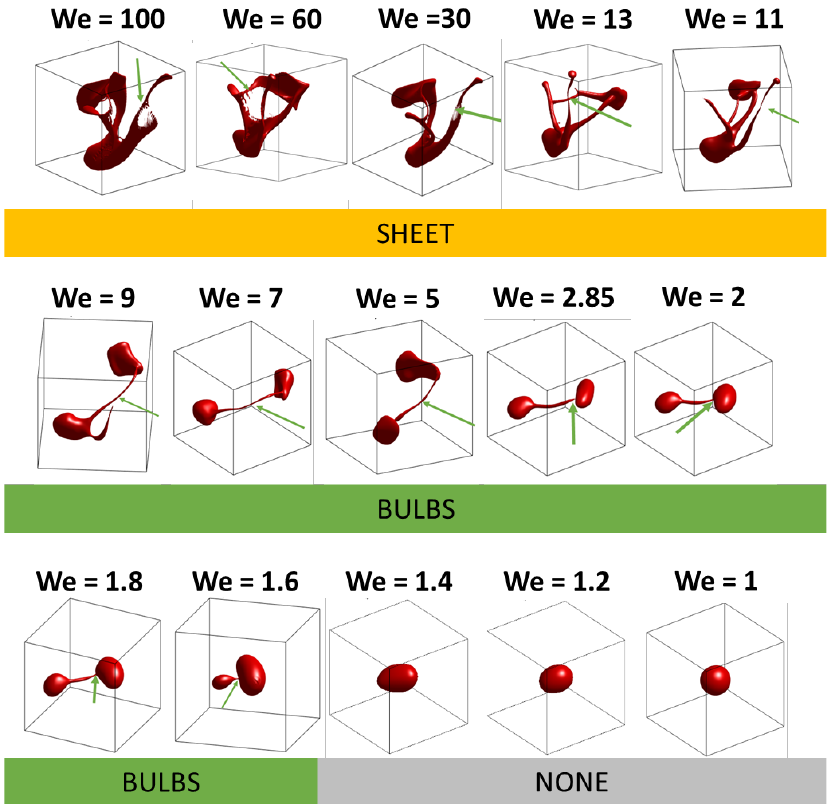
Figure 2. Morphology at the initial breakup as a function of Weber number for a low viscosity drop ( μ D /μ C = 1). Green arrows show the point of initial detachment.